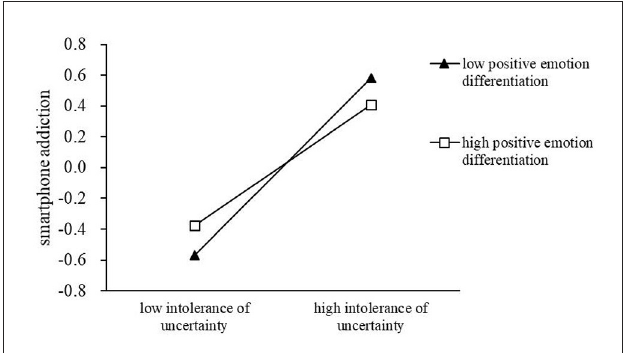
FIGURE2 Simple slope plot of positive emotion differentiation.